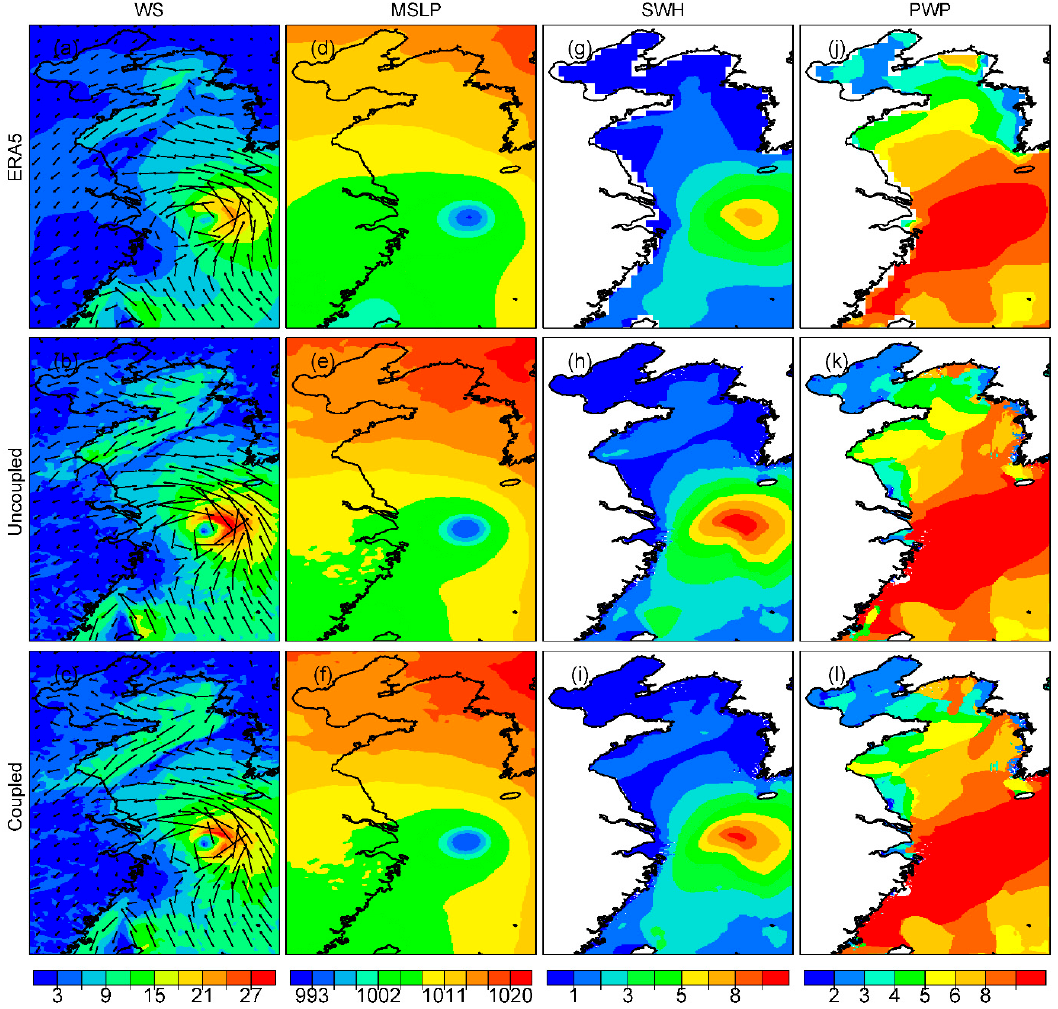
Figure 14. Snapshots of wind speed (WS, m/s) and wind vectors ( a – c ), mean sea level pressure (MSLP, hPa, d – f ), significant wave height (SWH, m, g – i ) and peak wave period (PWP, s, j – l ) for ERA5 reanalysis, uncoupled simulations and coupled simulation at 01:00 UTC, 01 September 2010, when typhoon Kompasu was over the East China Sea. Here, uncoupled represents CCLM for WS and WAM_C for SWH, coupled represents CCLM-WAM for WS and SWH.